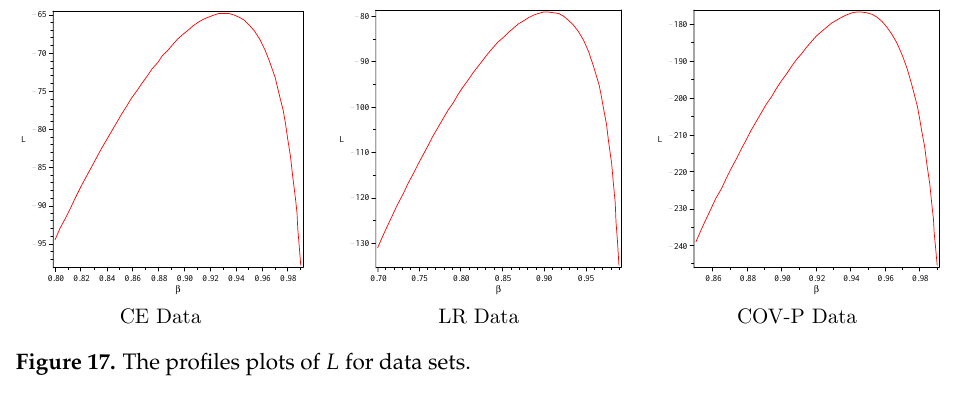
Figure 17 . The pro(cid:133)les plots of L for datasets. Figure 17. The profiles plots of L for data sets.